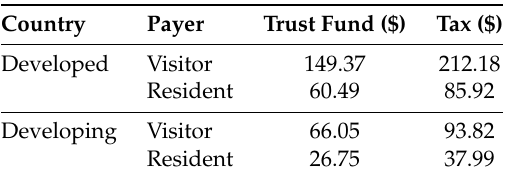
Table 4. WTP for charismatic endangered bald eagle (tax vs. trust